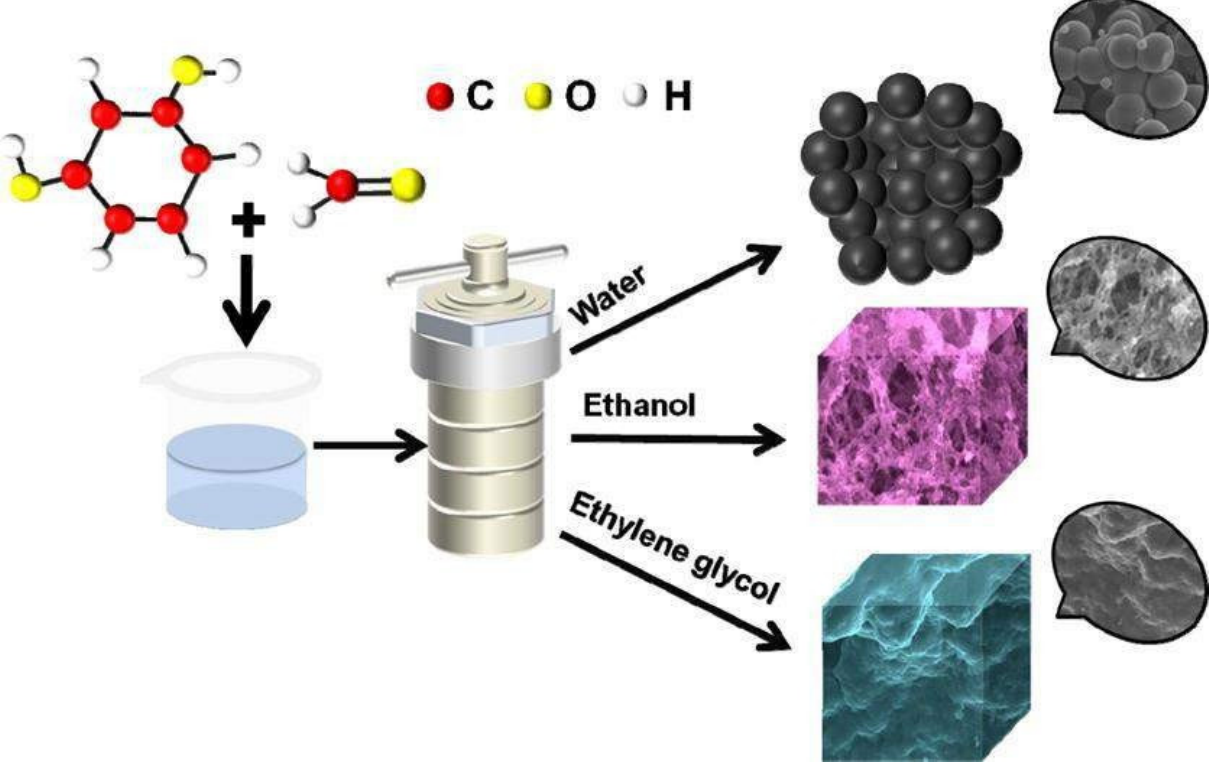
Figure 32. Controlled porous carbon synthesis and electrochemical performance of supercapacitors. Reproduced with permission from [118].